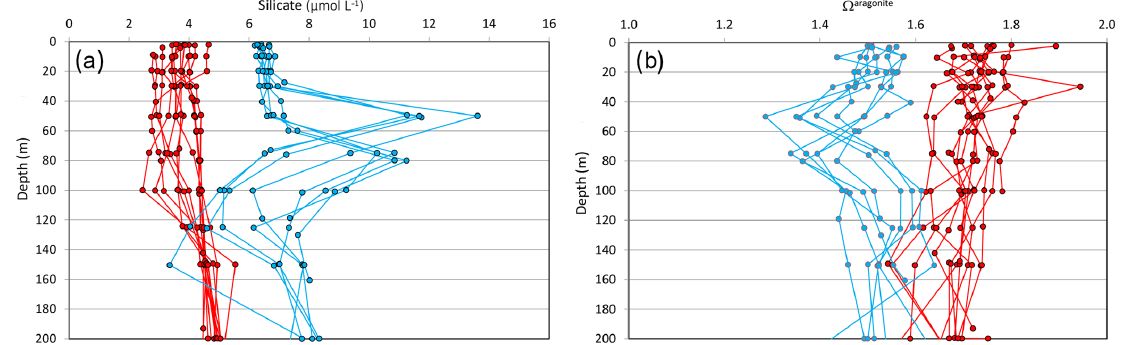
Figure 9. Depth profiles of silicate (a) and (cid:127) aragonite (b) in the Fram Strait around 82 ◦ N in 2002. The 2002 (cid:127) aragonite values are all computed from pH and TA and cover the whole strait. There is a distinct difference in both the silicate and (cid:127) aragonite properties in the north-flowing Atlantic water (red with a surface salinity around 34.5) and the south-flowing Arctic waters (blue with a surface salinity around 32). Both in- and outflowing water has a surface temperature below − 1 ◦ C, making the effects of salinity and temperature on (cid:127) aragonite in the order of maximum